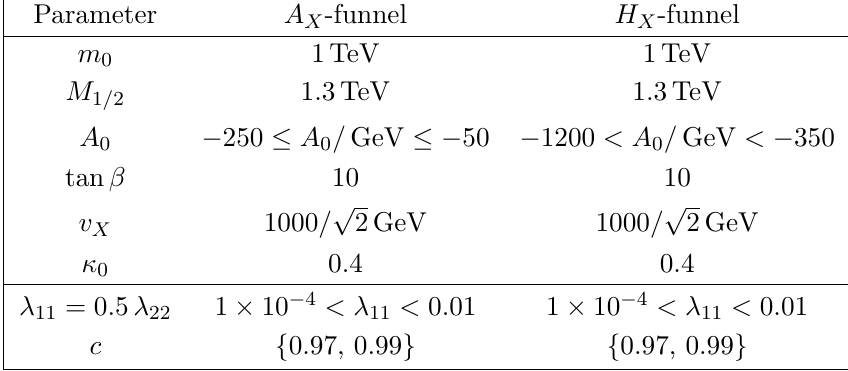
Table 2 . Parameters used in our numerical scans. We take (cid:22) NS and (cid:21) to be diagonal matrices. For more details, in particular on how we determine (cid:22) NS see main